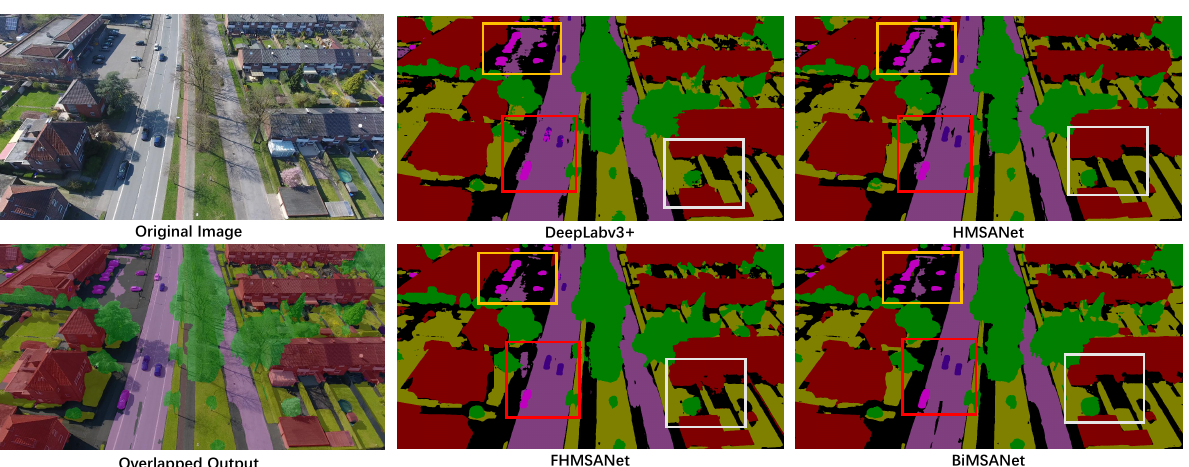
Table 1. Performance comparisons for different models in intersection-over-union metric. The top ranked scores are marked in colors. Red for the 1st place, green for the 2nd place, and blue for the 3rd place.